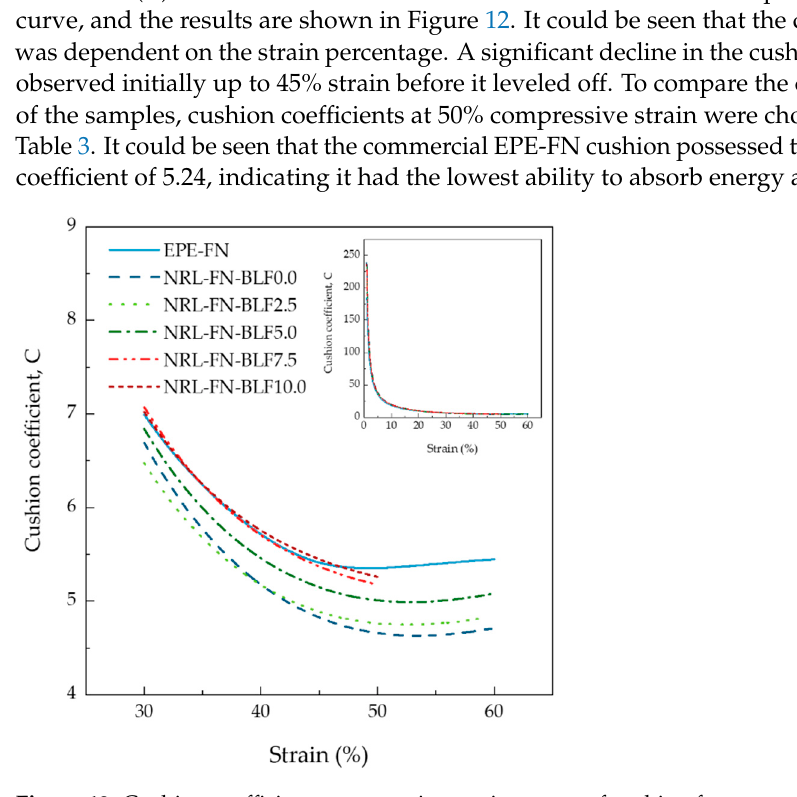
Figure 12. Cushion coefficient–compressive strain curves of cushion foams.